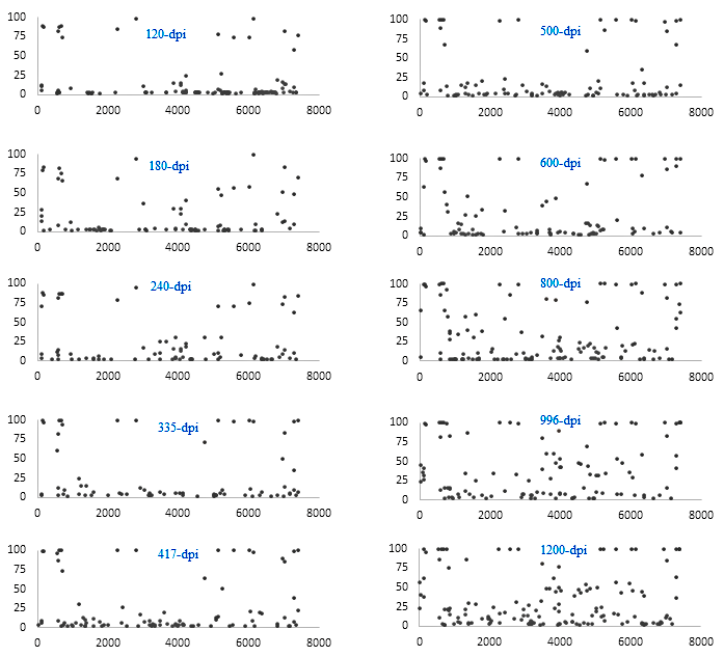
Figure 2. Distribution of single nucleotide variants across the F4-C1 genome at different time points. Each dot represents each SNV identified by NGS at the nucleotide position along the mapped reference sequence of F4-C1 genome at 62 dpi ( x -axis) with its variant frequency ( y -axis) at that position. Only those variants with a frequency >2% are represented in the graphs.